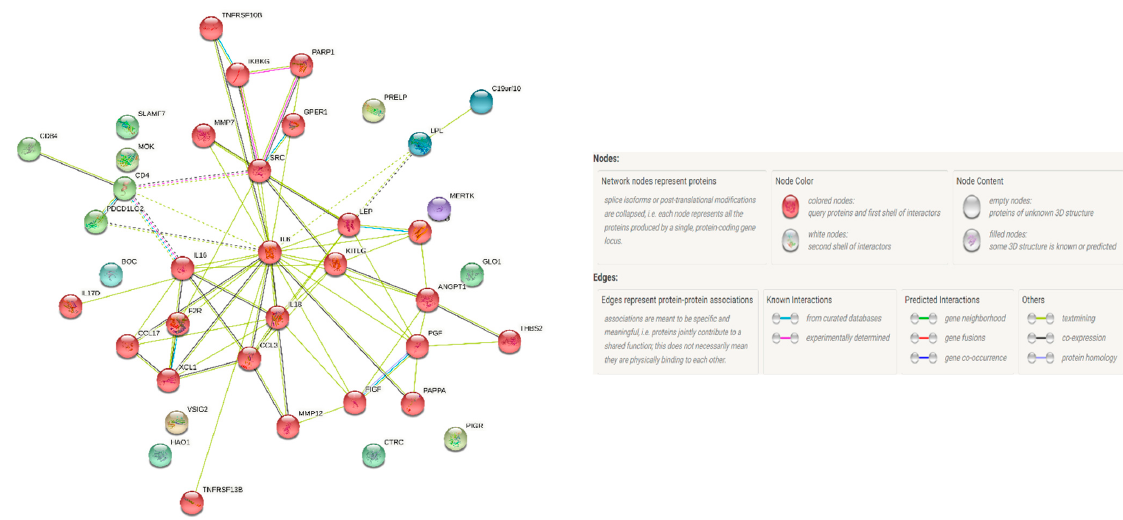
Figure 3. Protein–Protein interactions (PPI) showing networking of 43 CVD related biomarkers identified to be increased in RA with PD patients. The cluster shows frequent and strong interactions (represented by the same color of the nodes).